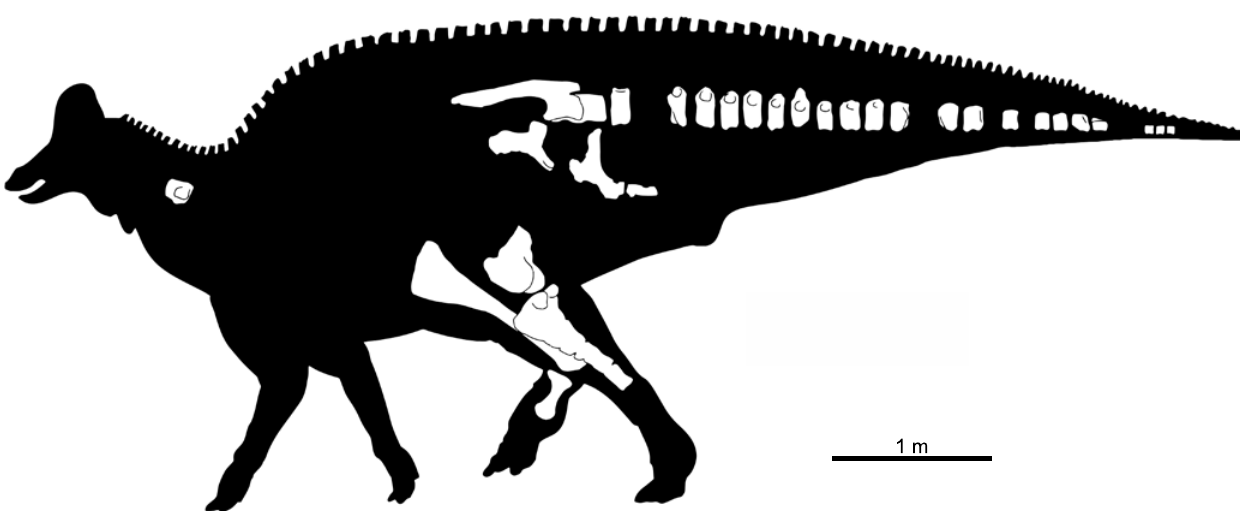
Fig. 2. Skeletal composition of the FCBUANL_2711. The silhouette was obtained from phylopic.org vectorized by T. Michael Keesey from the work of Dmitry Bogdanov.